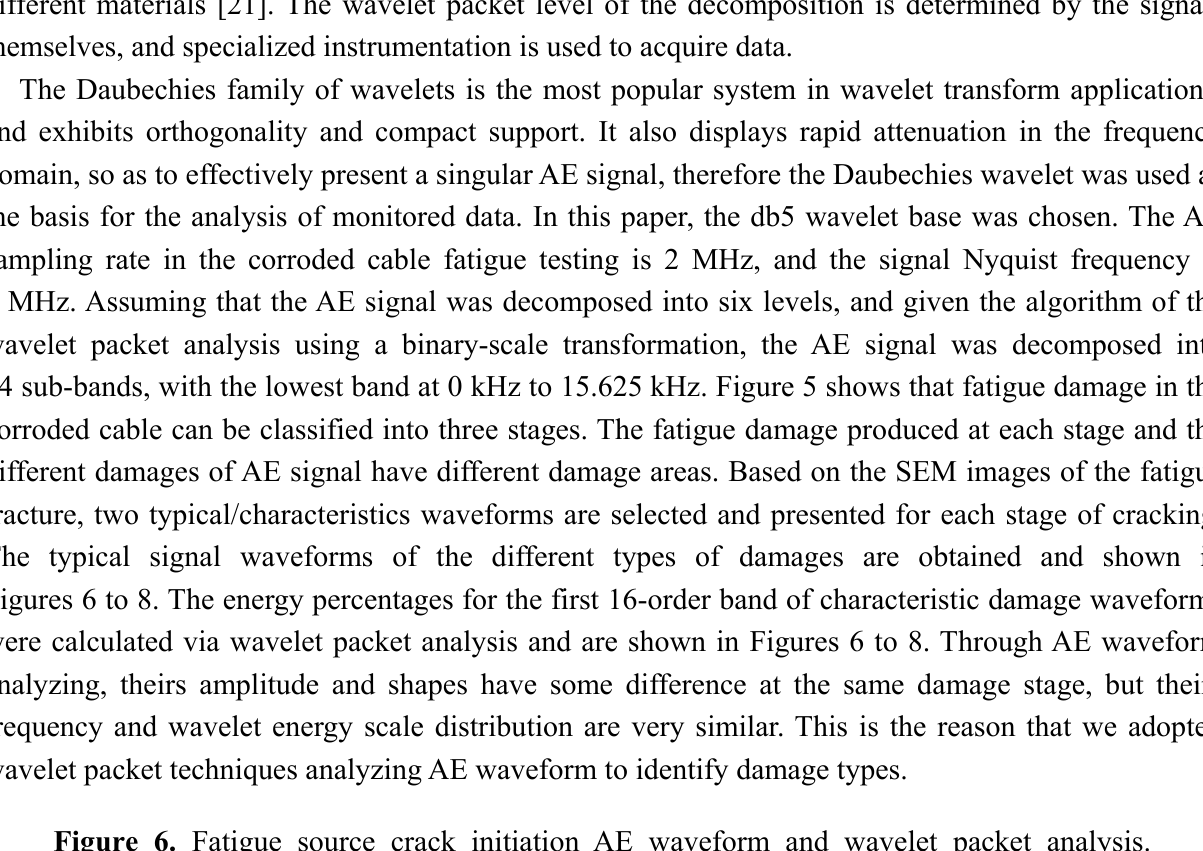
Figure 6. Fatigue source crack initiation AE waveform and wavelet packet